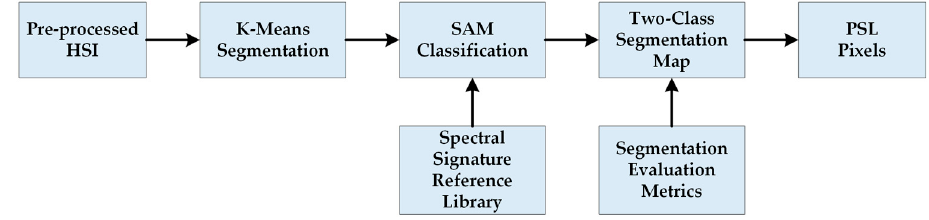
Figure 5. Block diagram of the HS dermatologic segmentation framework. Table 2. K value using Silhouette, Calinski Harabasz and Davies Bouldin clustering evaluation methods.